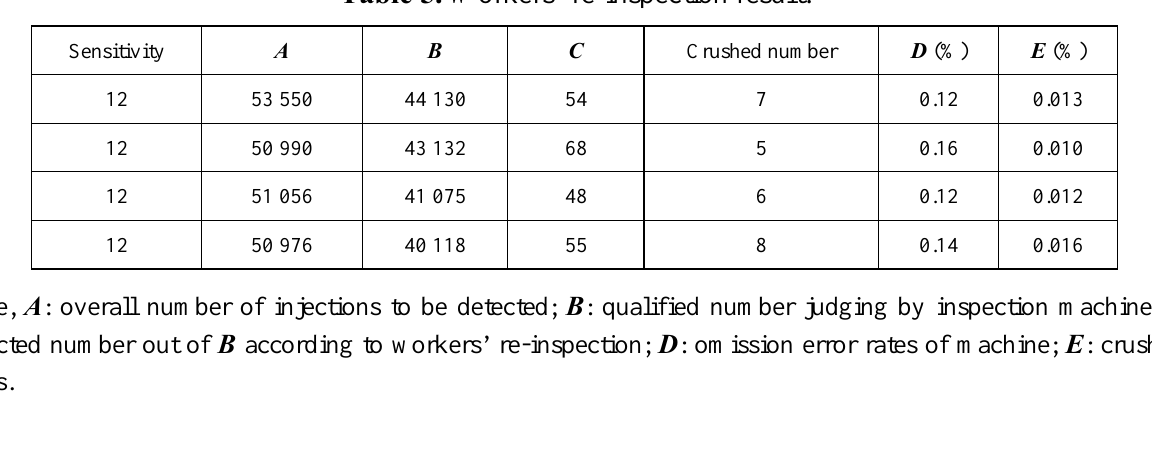
Table 5. Workers’ re-inspection